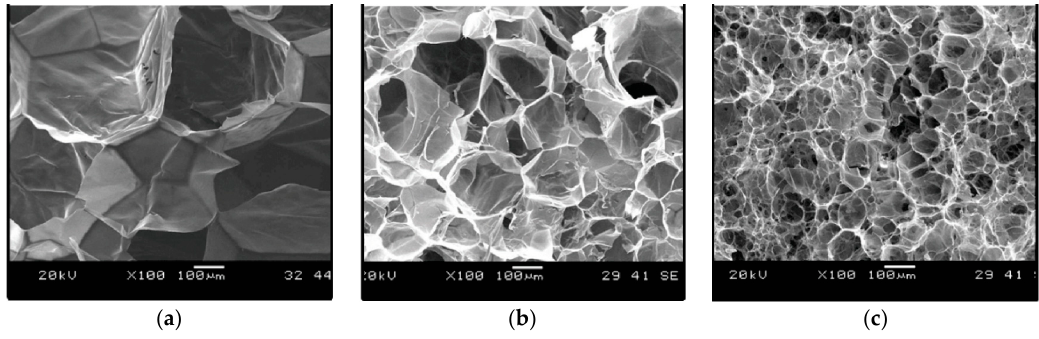
Figure 7. Foam morphology: ( a ) Neat PLA, ( b ) PLA/MF composites, and ( c ) PLA/CNF composites (3